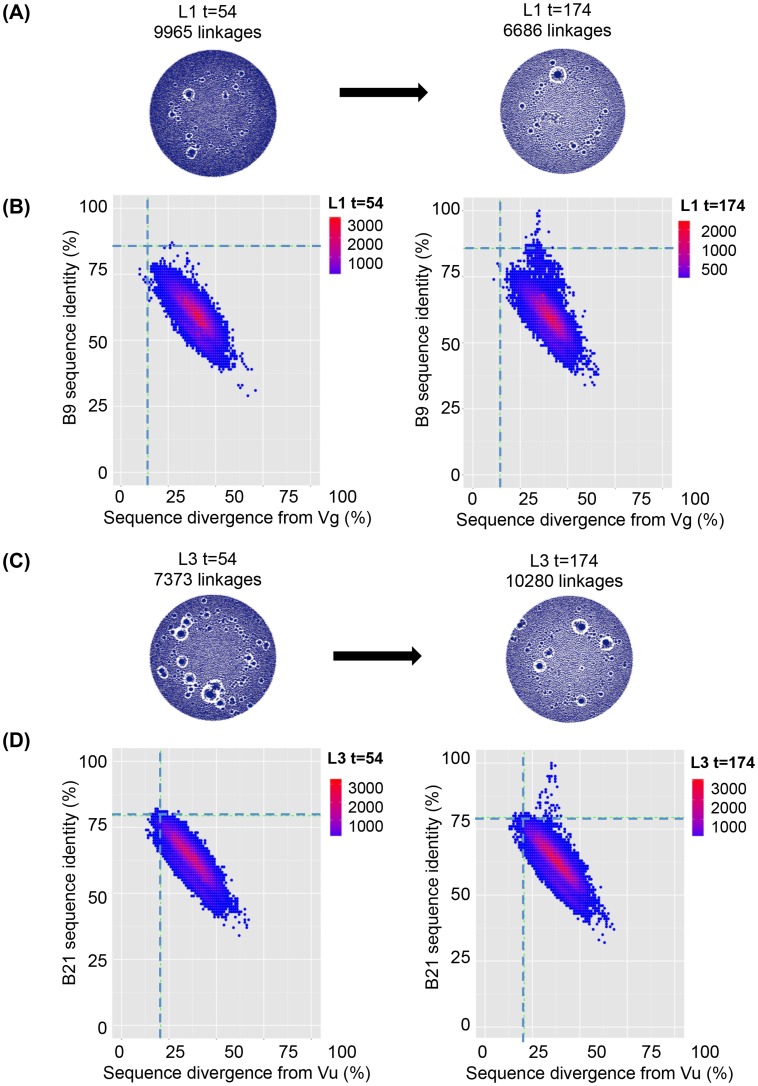
VHH repertoires post DNA/VLP priming and gp140 boosts.VHH sequences from immunized llama 1 at both t = 54 and t = 174 were amplified from their respective phagemid libraries by PCR using primers specific to the 5′ and 3′ conserved regions of the VHH and subjected to 454 sequencing. (A) Unique sequences generated from the llama 1 were used to build end-joining network diagrams with no significant difference in the number of network linkages between time points (B) Shared percentage identities with neutralizing VHH B9 its inferred V genes Vg were calculated for all unique sequences from both time points. Percentage identity with B9 for all sequences are plotted against divergence from Vg for t = 54 in the left hand panel and t = 174 in the right hand panel. (C) Unique sequences generated from the llama 3 were used to build end-joining network diagrams with no significant difference in the number of network linkages between time points (D). Shared percentage identities between neutralizing VHH B21 and its inferred V genes Vu were calculated for all unique sequences from both time points. Percentage identity with B21 for all sequences is plotted against divergence from Vu for t = 54 in the left hand panel and t = 174 in the right hand panel. In both (B) and (D) the horizontal dotted line on each panel indicates the percentage identity shared by the mature and germ line VHH and the vertical dotted line indicates the divergence of the mature VHH from its putative germ line precursor.